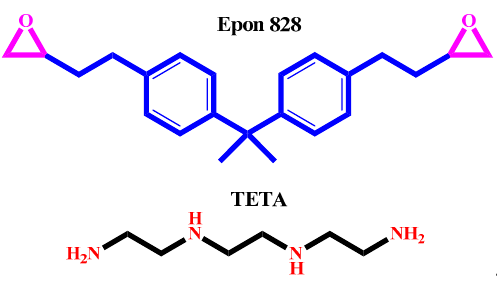
Figure 1. Chemical structure of Epon 828 and